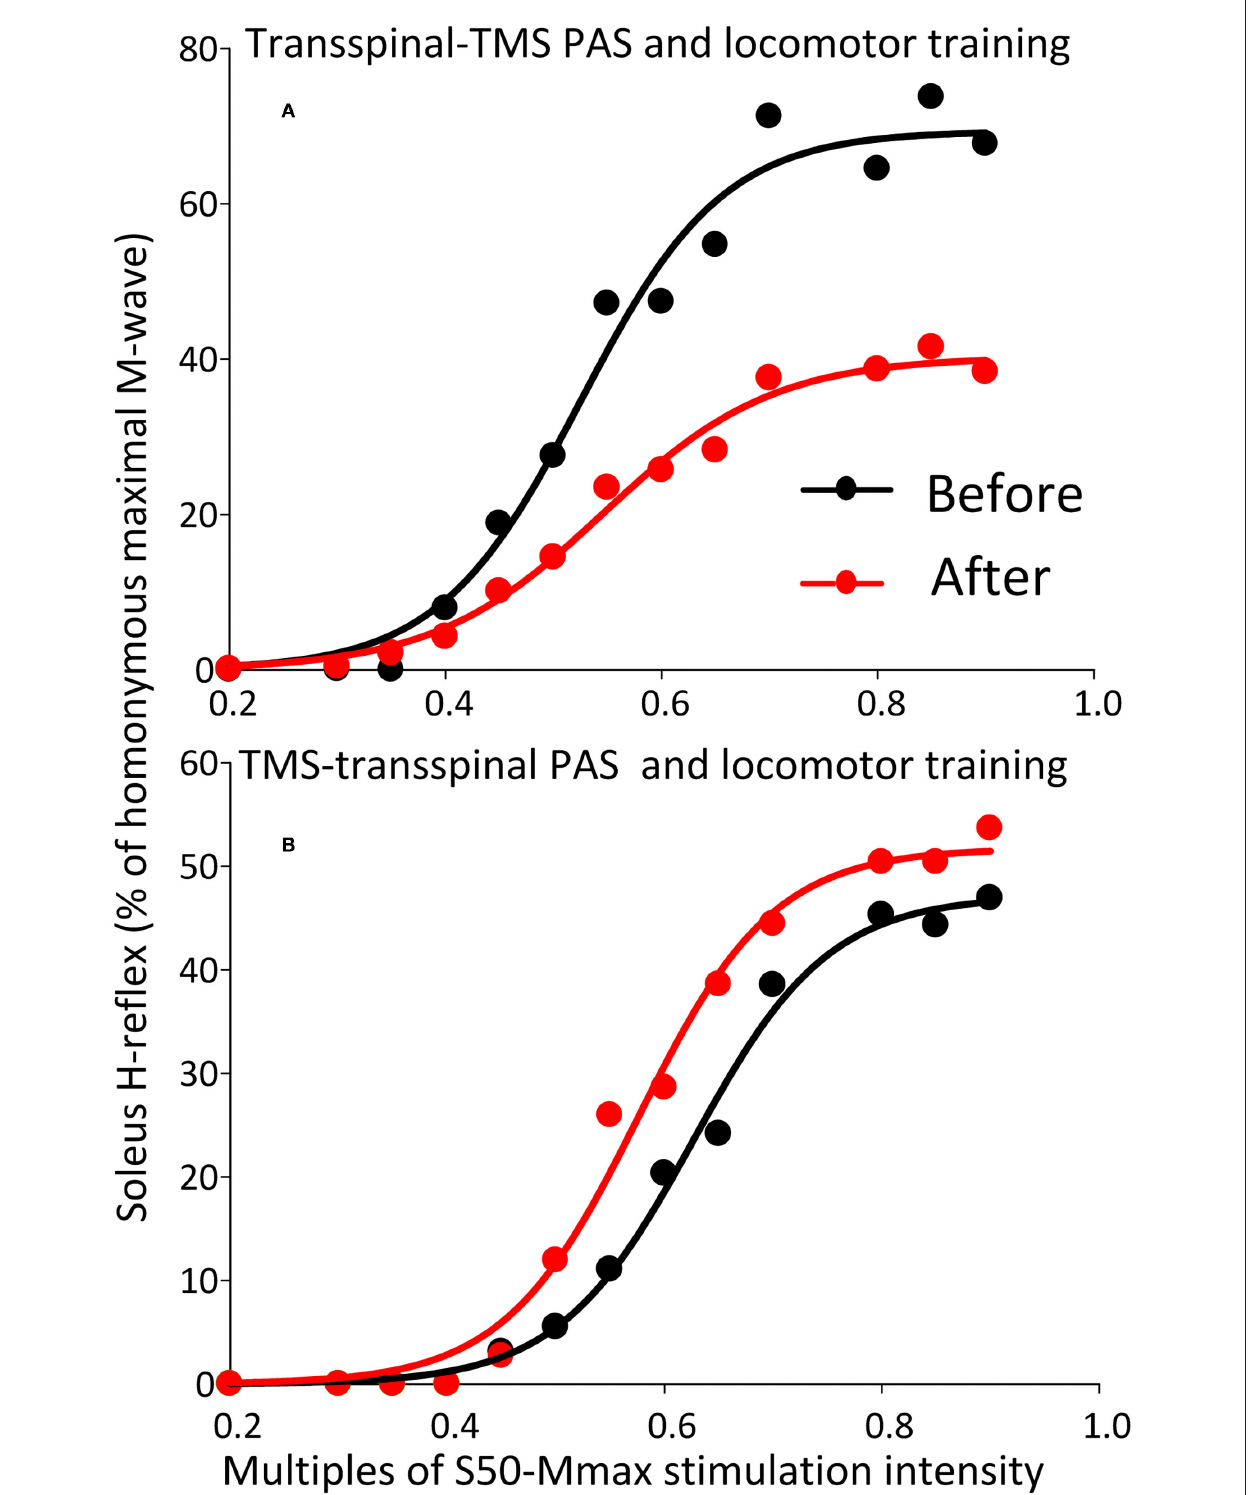
FIGURE 8 | Soleus H-reflex recruitment input-output curves before and after training grouped based on TMS targeted leg. Soleus H-reflex recruitment input-output curves grouped based on the TMS less impaired targeted leg recorded at different stimulation intensities during body weight supported standing before and after transspinal-TMS (A) PAS and TMS-transspinal PAS (B) and locomotor training. Sigmoid functions are fitted to the input-output curves. PAS, paired associative stimulation; TMS, transcranial magnetic stimulation.